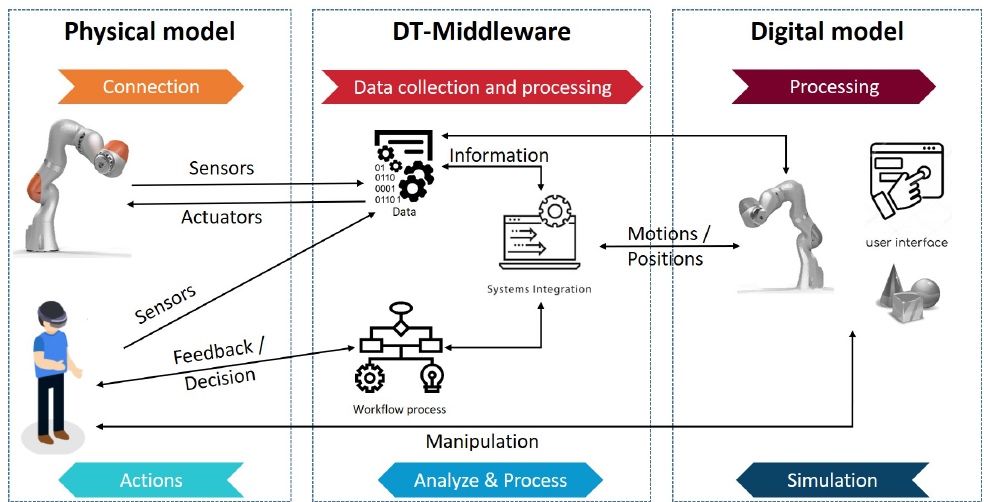
Figure 5. The IoT architectural